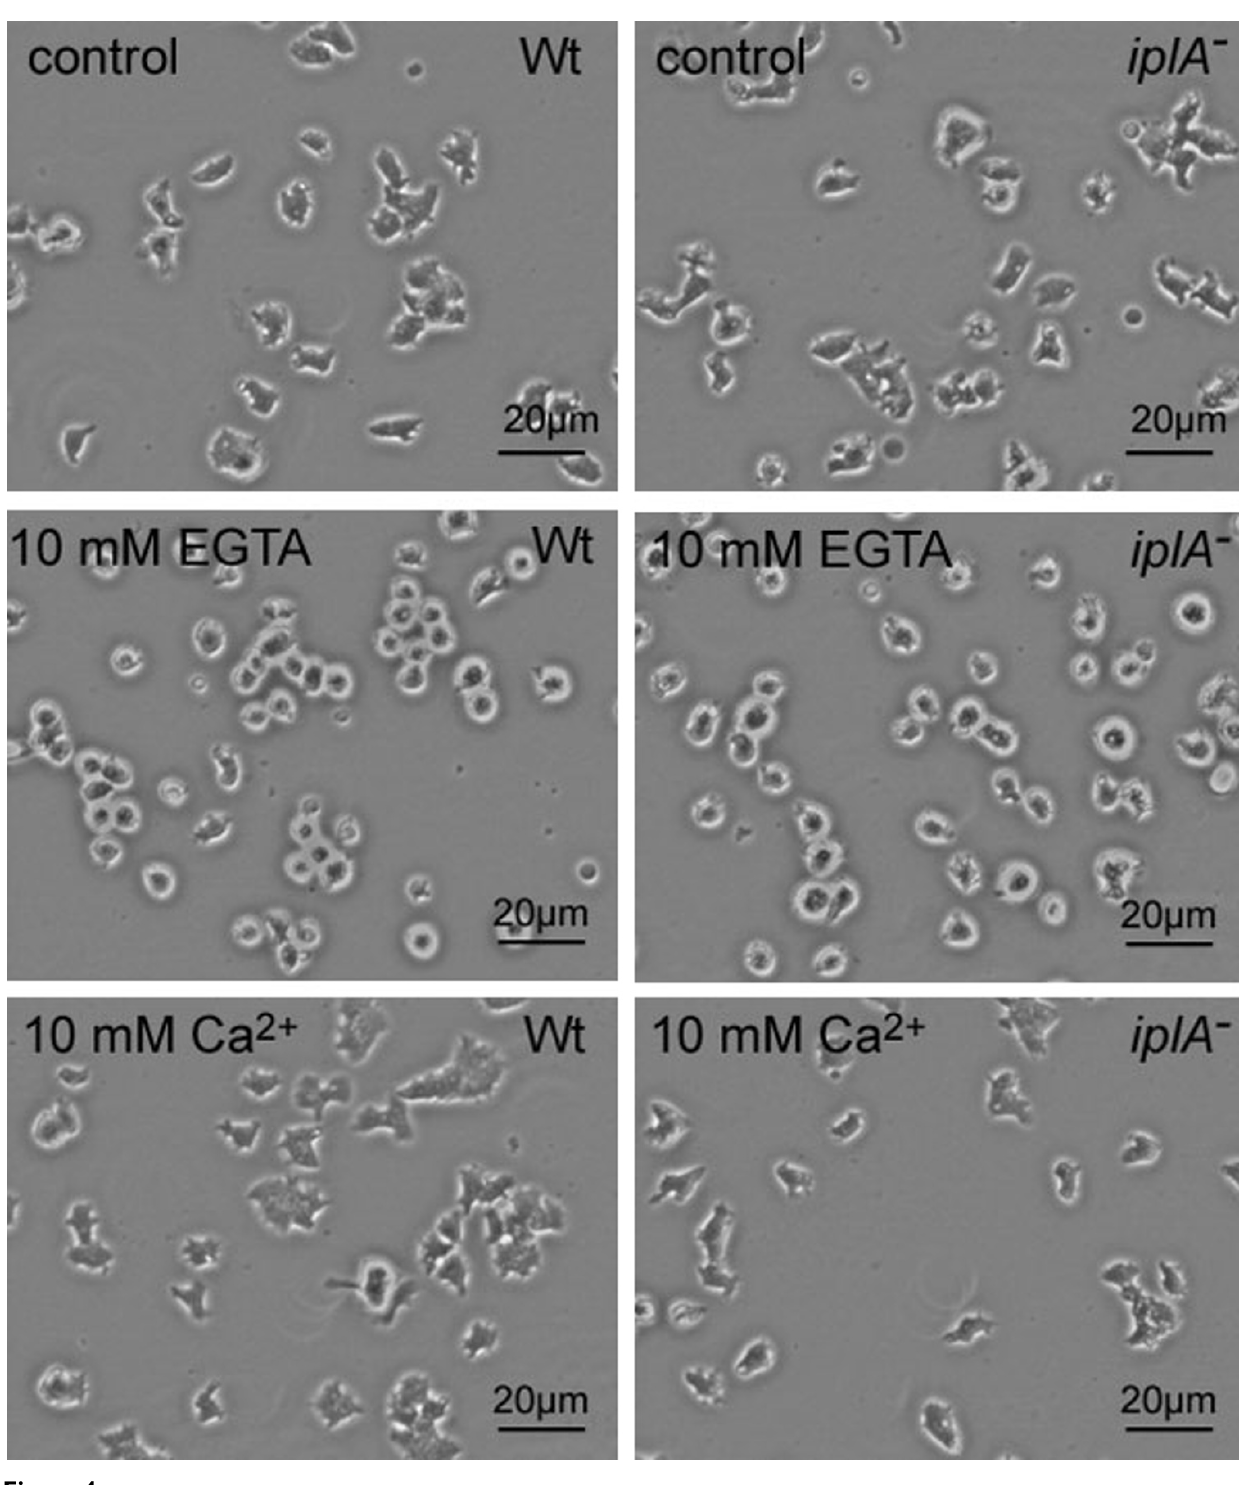
Figure 4 General morphology of wild type and iplA - cells under control conditions (A, B), in the presence of 10 mM EGTA for 60 min (C, D) or in the presence of 10 mM CaCl for 80 min (E, F). In H5-buffer or in the presence of 10 mM CaCl 2 not significantly different between wild type and mutant amoebae. However, in the presence of EGTA the cells of both strains were rounded. Photographs were taken at t . Basal motility under these conditions can be viewed in the accompanying 5